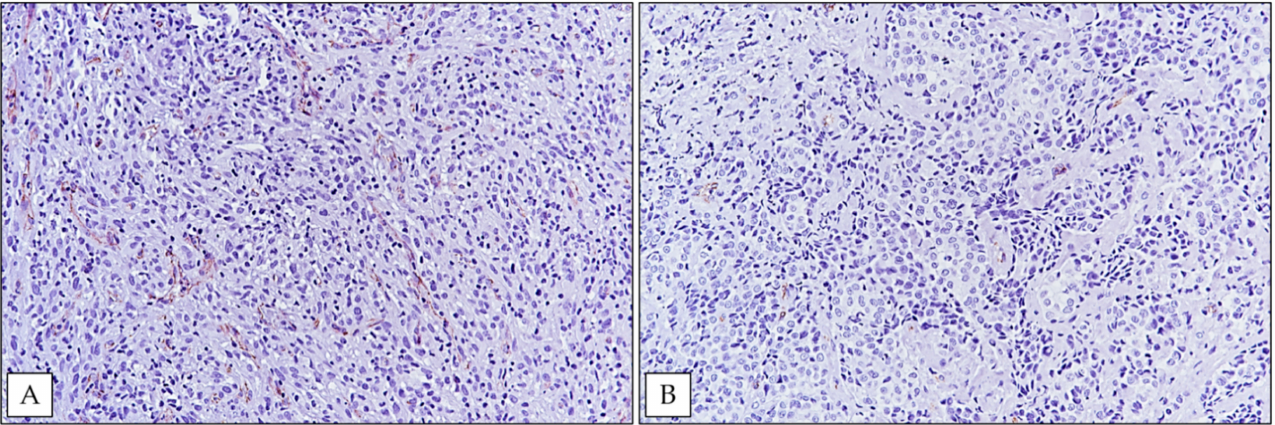
Figure 4. ( A ) High MVD in a biphasic MPM (immunoperoxidase staining; original magnification 200 × ); ( B ) an epithelioid